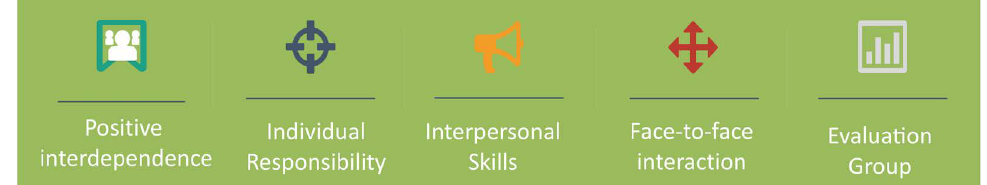
Figure 4. Essential pillars for collaborative learning to occur. Source: self-elaborated based on Krathwohl & Anderson